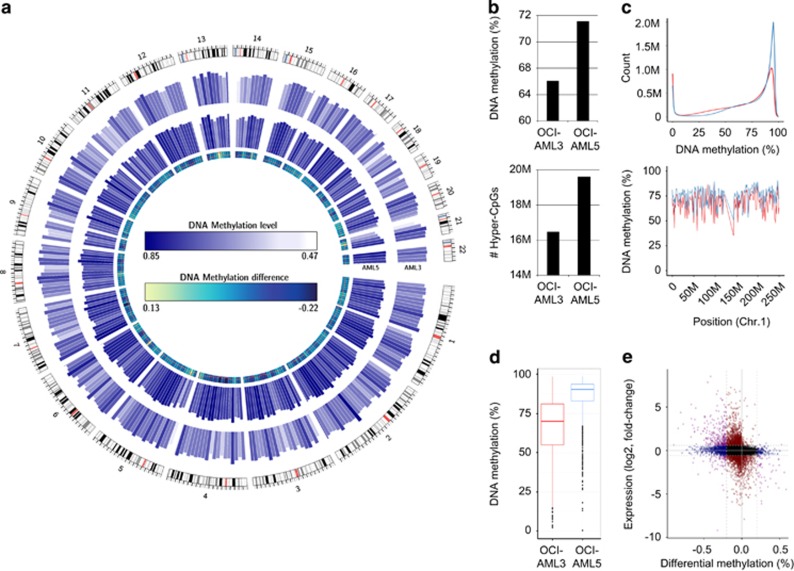
Complete DNA methylomes of DNMT3A wild-type and mutant AML cell lines. (a) Global DNA methylation levels in the DNMT3A mutant (OCI-AML3, outer circle) and wild-type (AML5, inner circle) cell lines analyzed by whole-genome bisulfite sequencing. Mean DNA methylation levels are displayed for 10 Mb genomic segments and all chromosomes. (b) Genome-wide analysis of DNA methylation levels at the CpG level (upper panel) and absolute number of hypermethylated (>0.66 methylation level; lower panel) CpG dinucleotides. (c) Genome-wide CpG methylation levels (upper panel) and DNA methylation profile exemplified by chromosome 1 (lower panel). (d) DNA methylation levels in DMRs hypomethylated in AML3. (e) Difference in promoter methylation (x axis; OCI-AML3 vs AML5) is associated with differential gene expression (y axis; OCI-AML3 vs AML5). Applied thresholds are indicated by dotted lines (δ DNA methylation >0.2; 1.5-fold change in gene expression). The 292 identified hypomethylated and overexpressed genes are highlighted in purple (upper left quadrant).